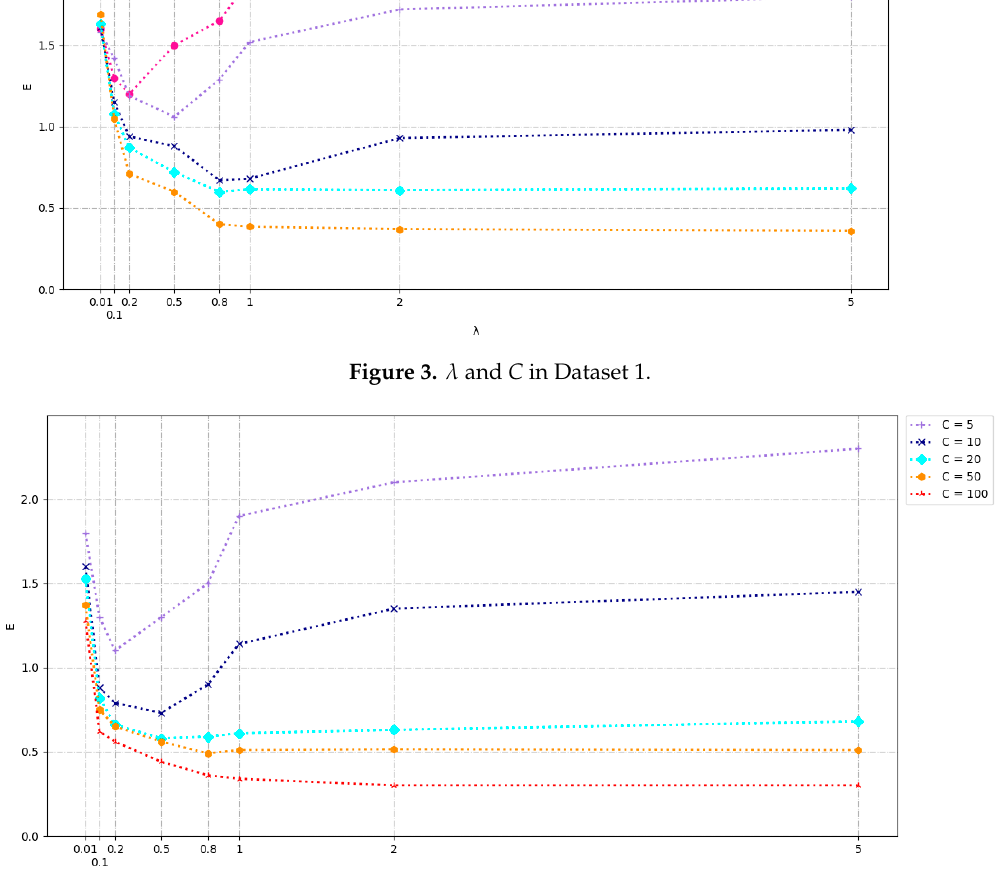
λ λ and C in Dataset and C in Dataset 2. Figure 4. λ and C in Dataset 2.